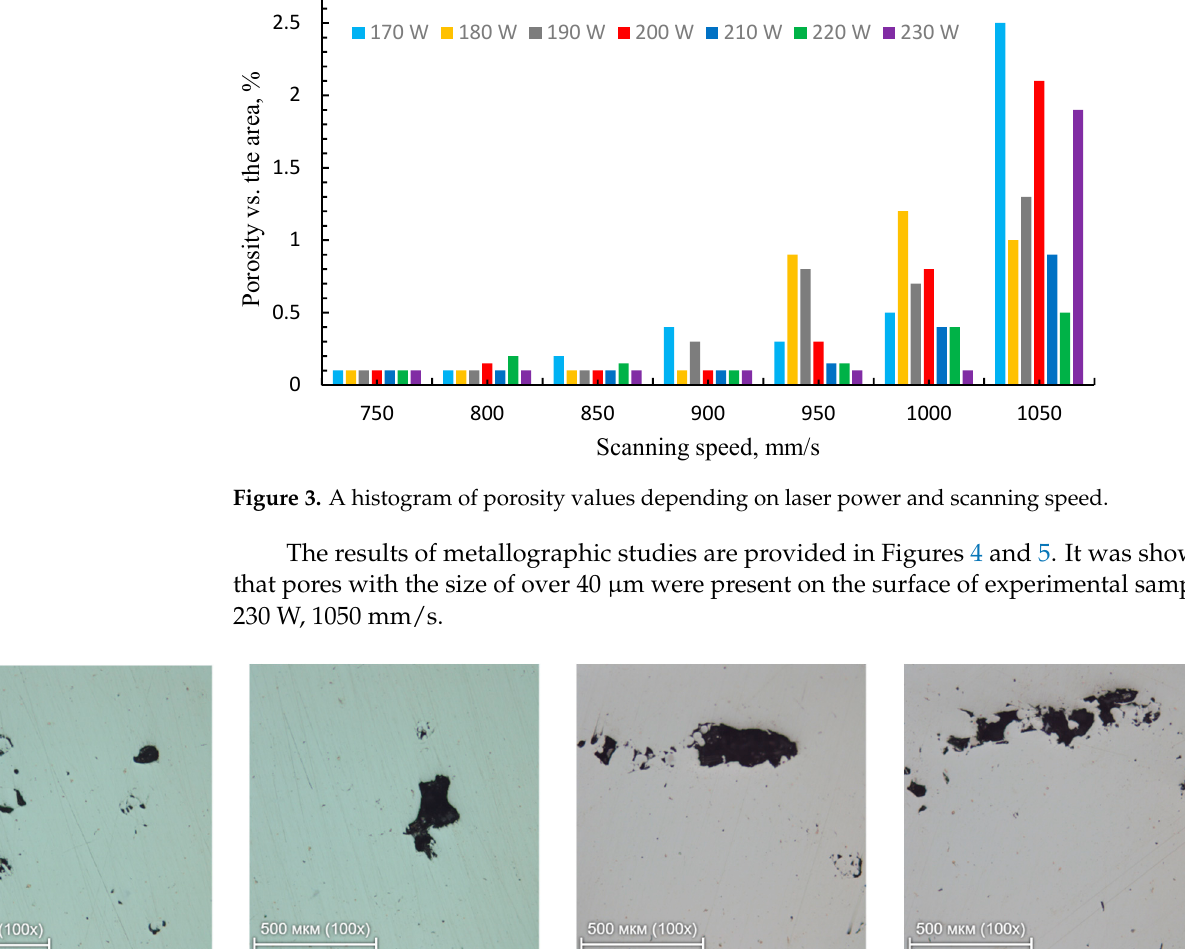
( b ) Figure 5. Photographs of the sample 200 W, 900 mm/s: ( a ) the topmost surface taken from different areas; ( b ) lateral surface taken from different areas.